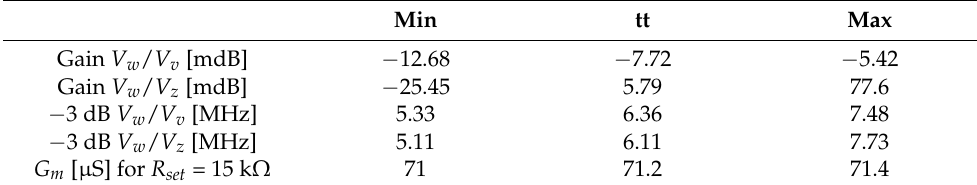
Figure 12. A histogram of the − 3 dB bandwidth V w / V z with 200 runs MC analysis. The process, voltage, temperature (PVT) corner analysis was also performed for the proposed VD-DIBA. The MOS transistor corners were [ss, sf, fs, ff], the capacitor corners were [slow, fast], the temperature corners were [ − 10 ◦ C, 80 ◦ C], and the voltage supply corners + V DD = − V SS were [895 mV, 905 mV]. The results of this analysis, including the minimum, typical, and maximum values, are summarized in Table 2 and confirm the acceptable performance of the circuit under PVT variations. Table 2. Process, voltage, temperature (PVT) corner analysis.